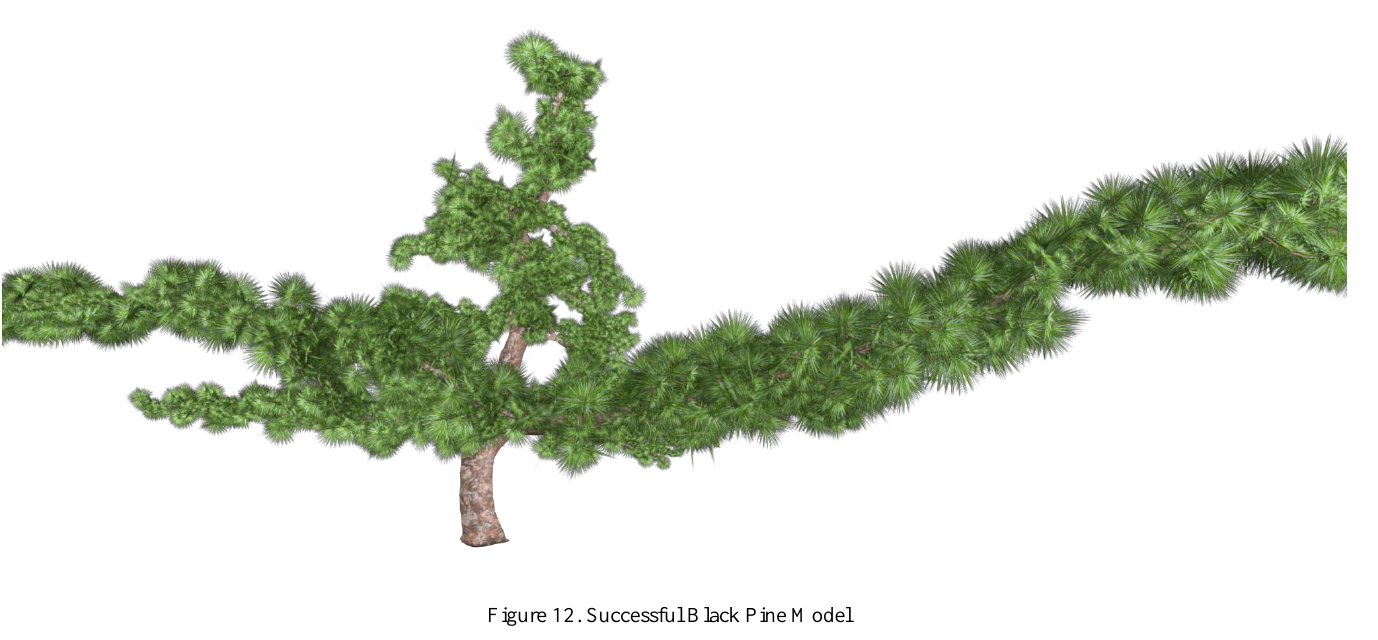
Figure 12. Successful Black Pine